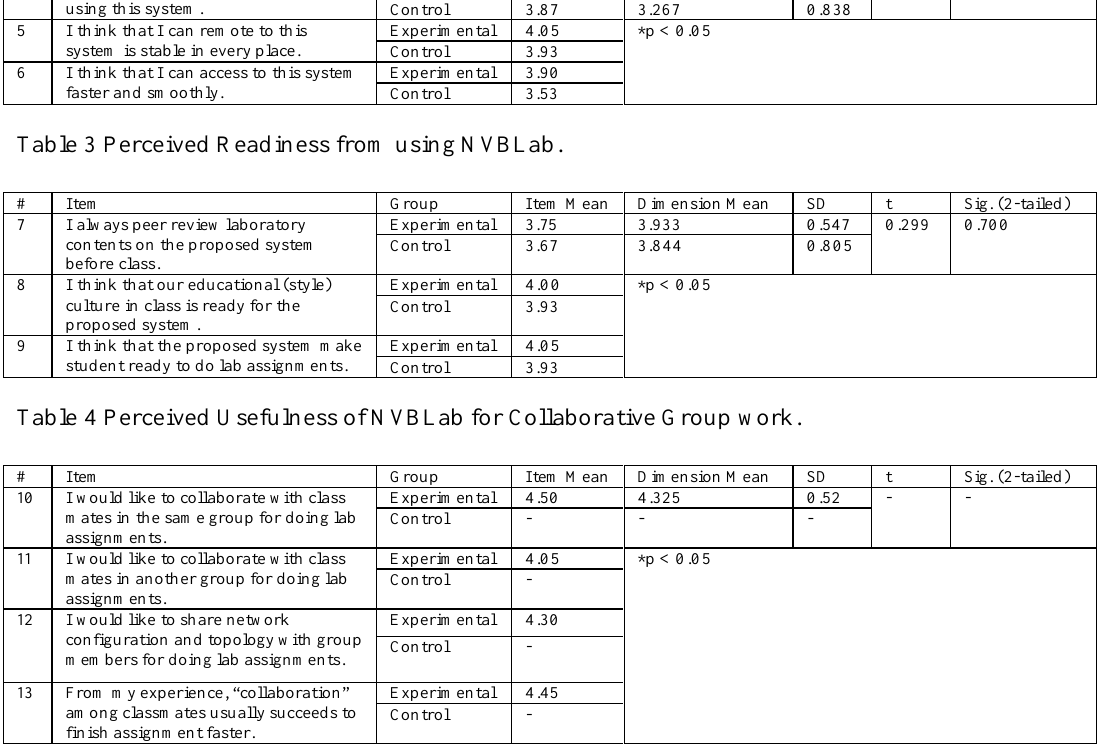
Table 5 Perceived Subjective Norm from Classmates to Use